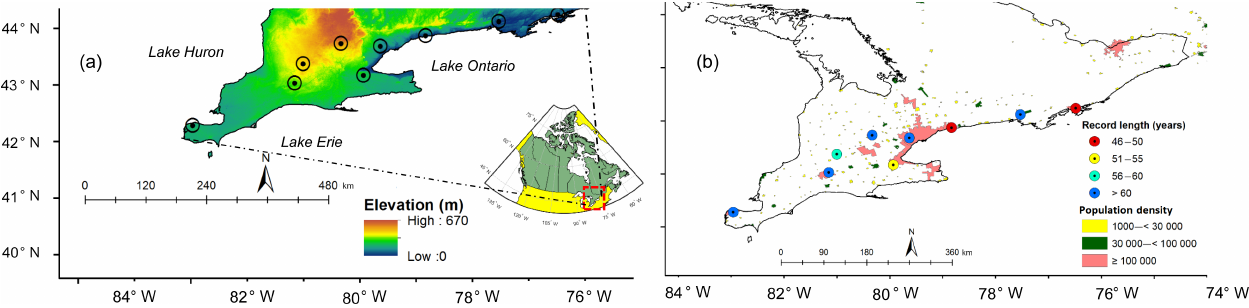
Figure 1. ( a ) Selected urbanized sites in Southern Ontario. Southern Ontario (41–44 ◦ N, 84–76 ◦ W) is the southernmost region of Canada and is situated on a southwest–northeast transect, bounded by lakes Huron, Erie, and Ontario. The nine locations on the map are (from the southwestern to northeastern corner): Windsor Airport, London International Airport, Stratford Wastewater Treatment Plant (WWTP), Fergus Shand Dam, Hamilton Airport, Toronto International Airport, Oshawa Water Pollution Control Plant (WPCP), Trenton Airport, and Kingston Pumping Station. Topography map indicates the maximum slope of 670m above mean sea level. ( b ) The population map shows six of the the sites: Windsor Airport, London International Airport, Hamilton Airport, Toronto International Airport, Oshawa WPCP, and Kingston P. Station are located either in or the vicinity of densely populated urbanized area. The remaining three sites are located in the moderately populated area. The short-duration AMP records in all locations vary between the minimum of 46 years and the maximum of 66